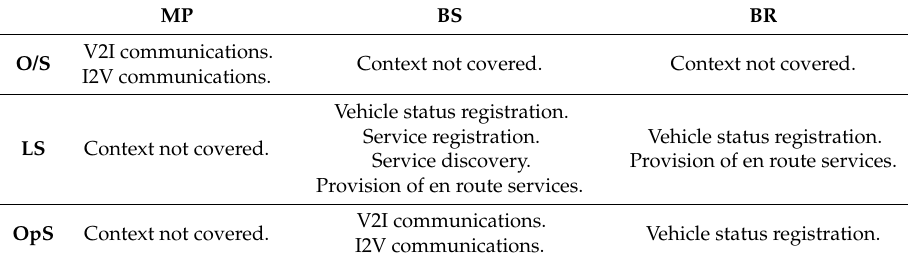
Table 1. Classification matrix of the different possible contexts and examples of actions to be taken in each.